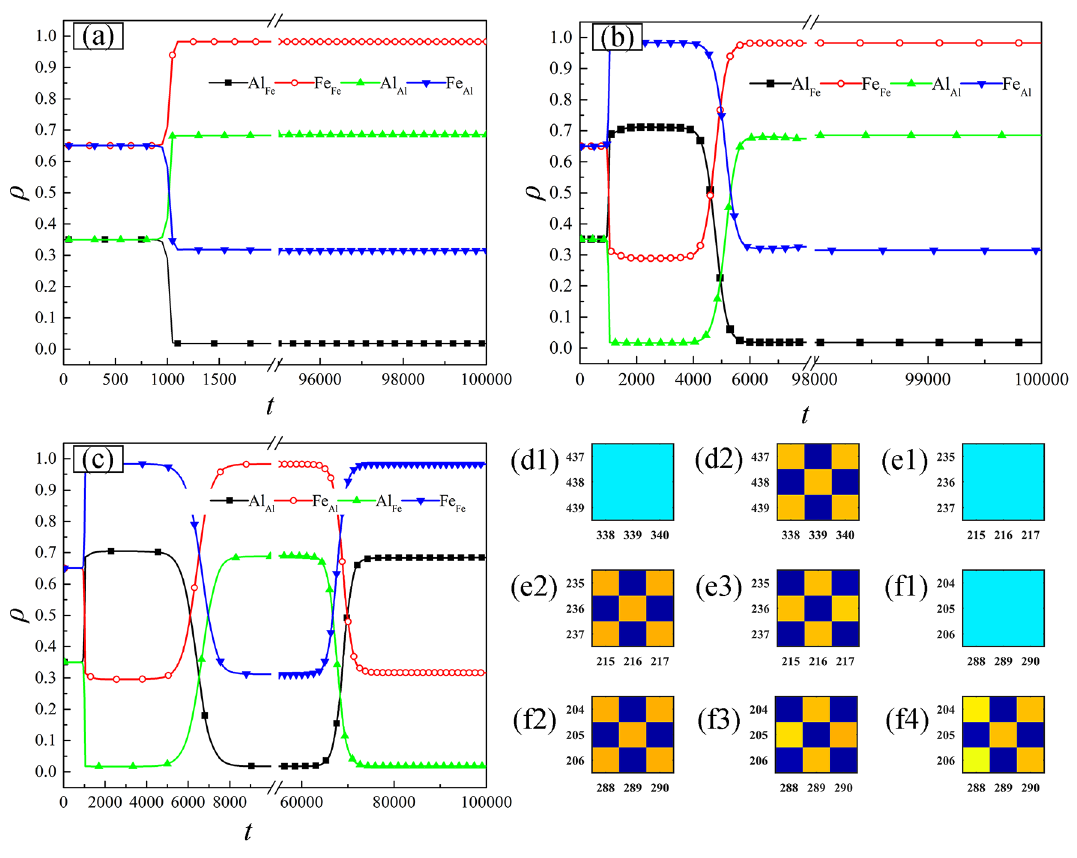
Figure 4. The changes of Fe- and Al-distribution functions versus time t . (a) No APDB pass. (b) Single APDB passes one time. (c) Two APDB totally pass two times. (d1-d2) The in situ FeAl crystal structure transformation in condition of (a), corresponding times t = 50, 1150, respectively; (e1-e3) The in situ FeAl crystal structure transformation in condition of (b), corresponding times t = 50, 1150, 5950, respectively; (f1-f4) The in situ FeAl crystal structure transformation in condition of (c), corresponding times t = 50, 1150, 8350, 72250,